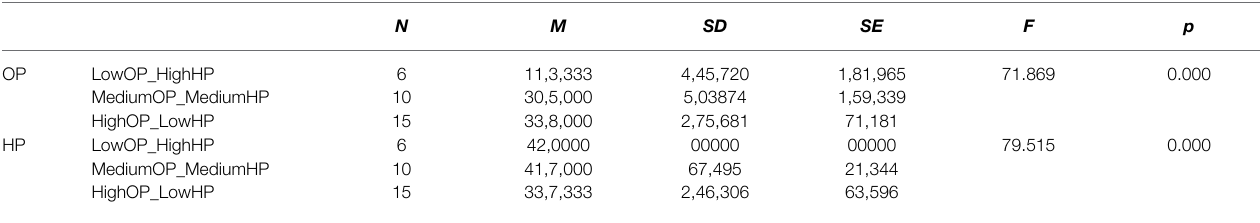
TABLE 2 | Grouping of participants into different passion profiles.